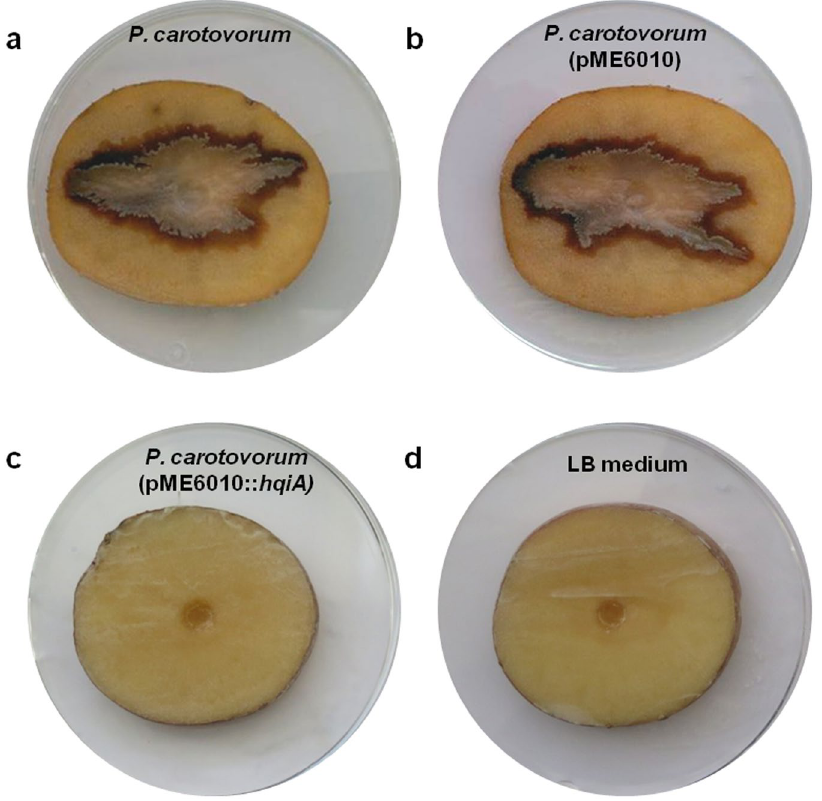
Figure 7. Virulence assay on potato tubers. Potato tuber slices inoculated with ( a ) Pectobacterium carotovorum without plasmid, ( b ) P . carotovorum (pME6010), ( c ) P . carotovorum expressing the hqiA gene and ( d ) cell-free LB